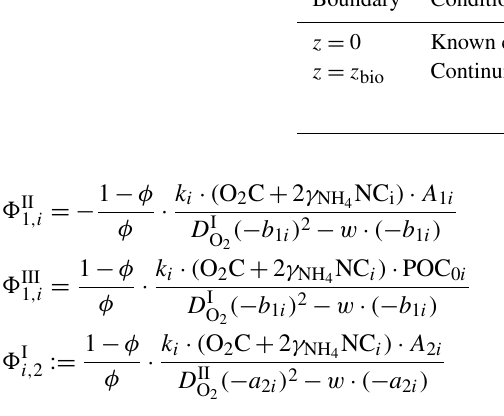
Table 2. OM Boundary conditions applied in OMEN-SED. For the boundaries we define z − h) .